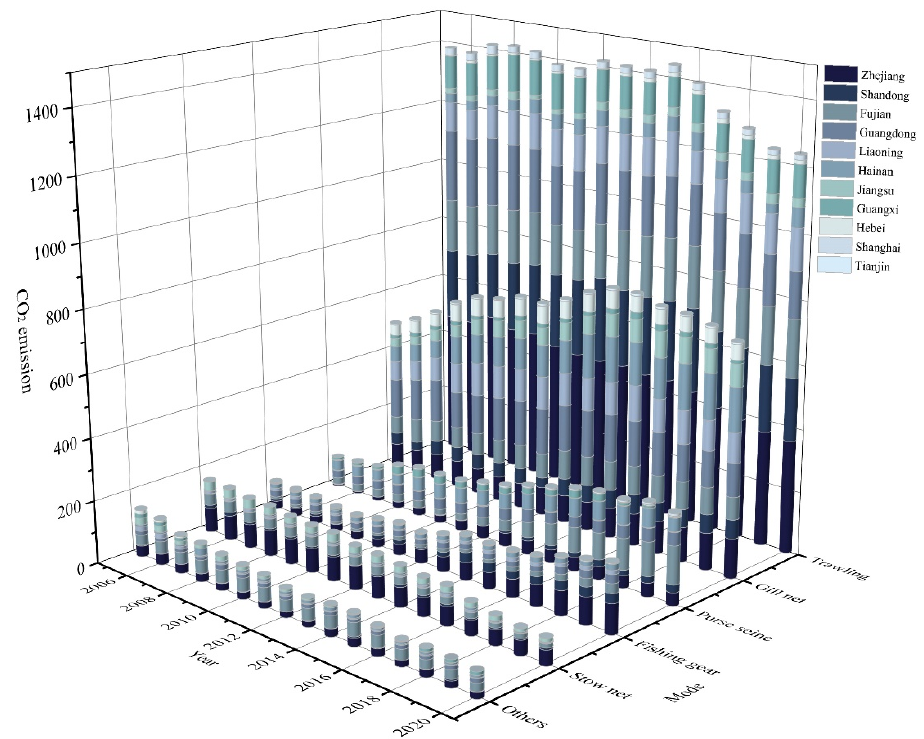
Figure 4. CO 2 emissions of marine fishing industry in different operation modes ( 10 (cid:2872) t).